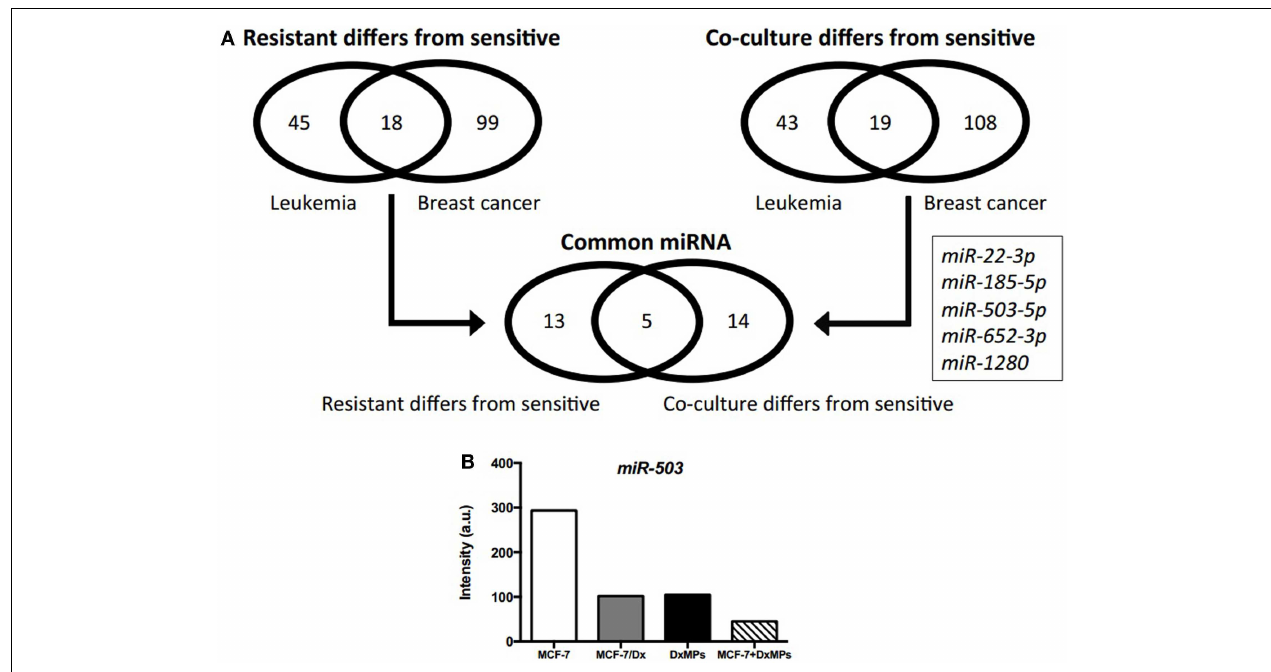
were common across both cancers that were differentially expressed in drug-resistant and co-cultured cells compared to drug-sensitive cells. (B) Expression of miR-503 as determined by microarray analysis. Microarray expression levels of miR-503 in ( ): MCF-7 cells, ( ): MCF-7/Dx cells, ( ): DxMPs, and ( ): MCF-7 cells co-cultured with